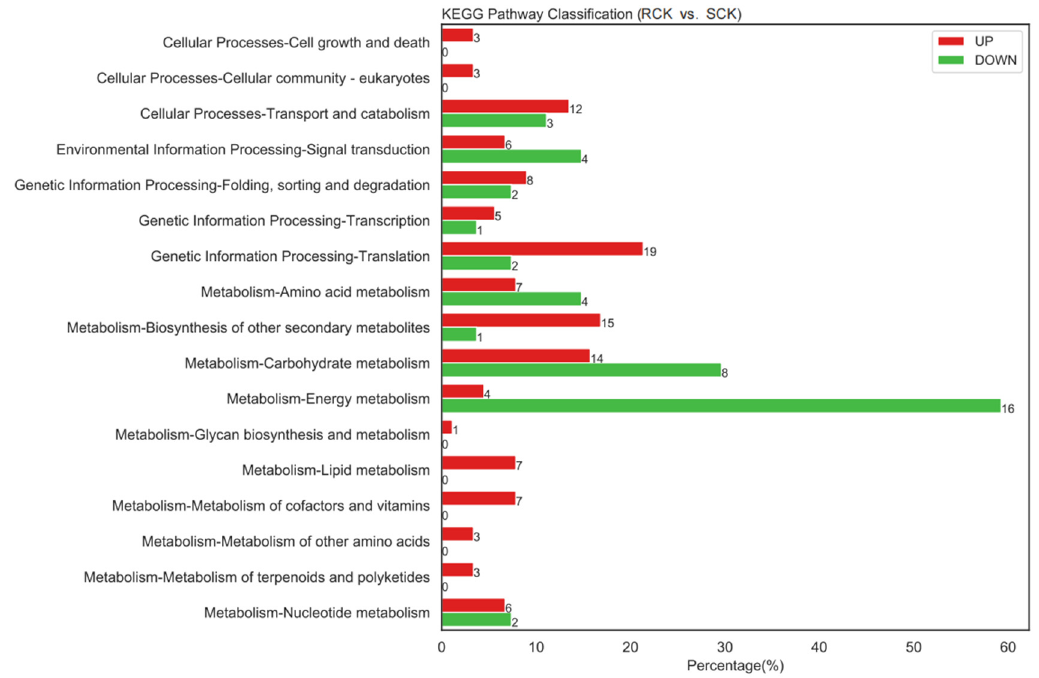
Figure 8. KEGG pathway enrichment analysis results between quinclorac-resistant (RCK) and -sensitive (SCK) E. crus-galli .